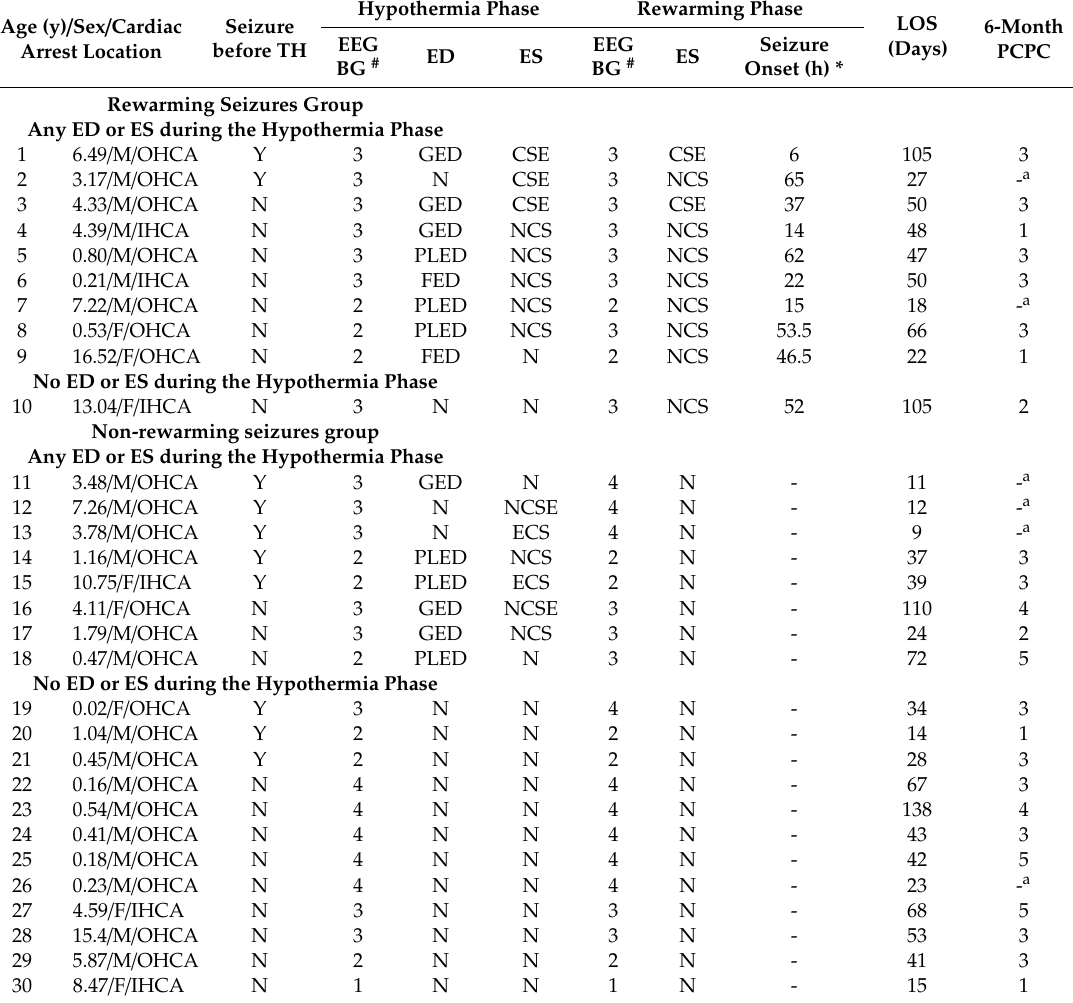
Table 3. EEG findings and clinical details of the 30 comatose children after